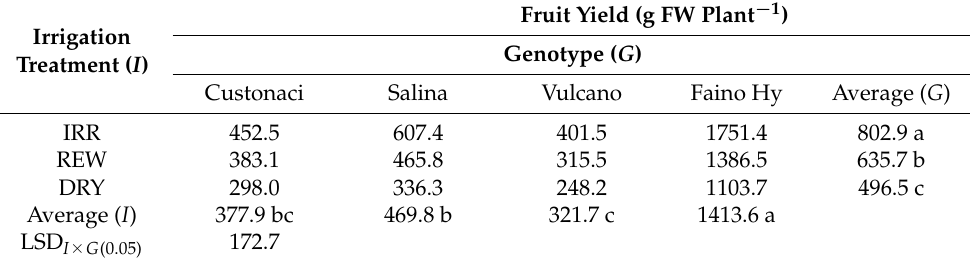
Table 3. Fruit yield per plant in four genotypes of tomato in relation to the irrigation treatment (IRR: full irrigation; REW: rewatering; DRY: no irrigation). For the main effects ( I = irrigation, G = genotype ), means followed by the same letter are not significantly different at p ≤ 0.05 (Tukey’s test). LSD interaction value is also reported.